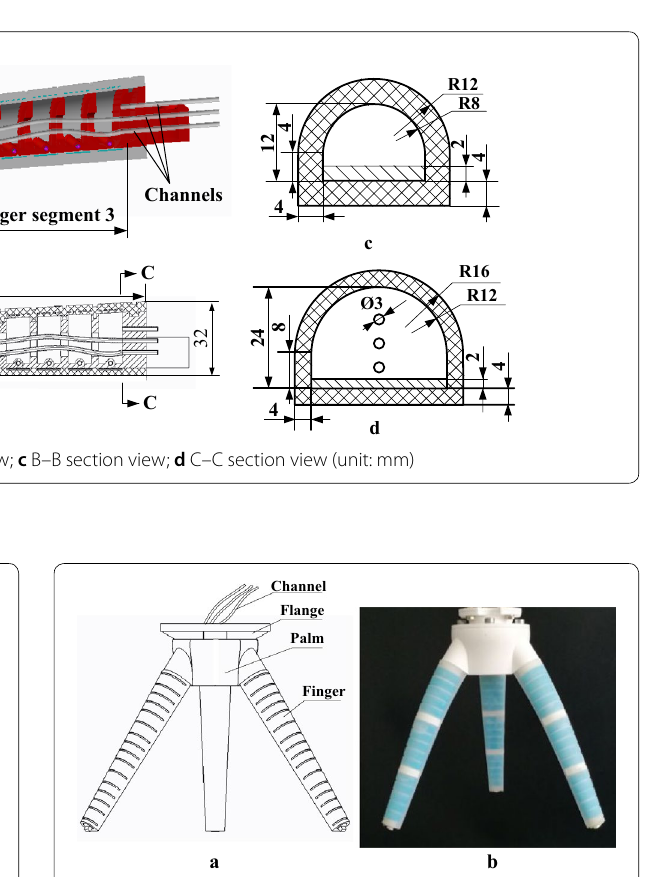
Figure 4 a Configuration of the E-Gripper; b Photograph of the